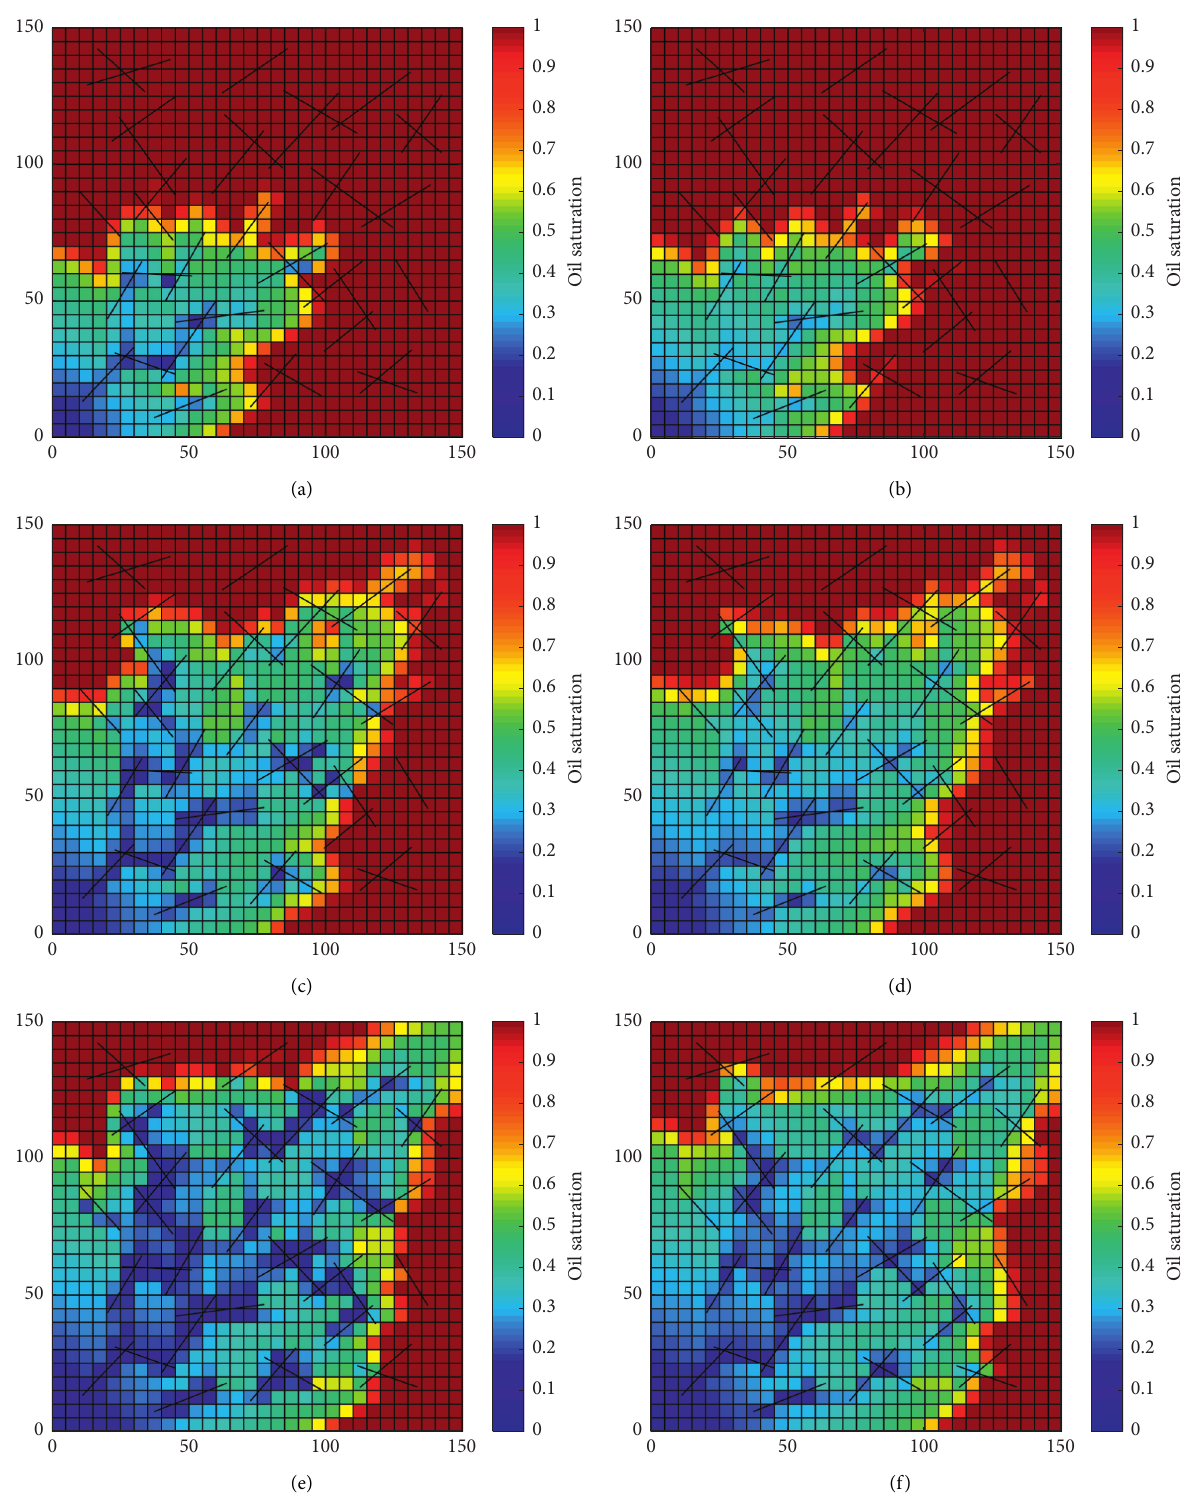
Figure 23: Oil saturation profiles for the pIEDFM simulation after (a) 5000days, (c) 10000days, and (e) 20000days of production and the EDFM simulation after (b) 5000days, (d) 10000days, and (f) 20000days of